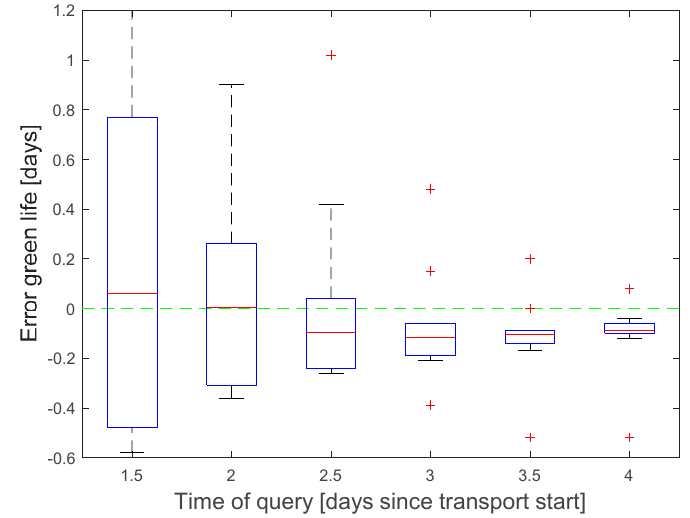
Figure 10. Boxplot of green life prediction error as function of query point of time.